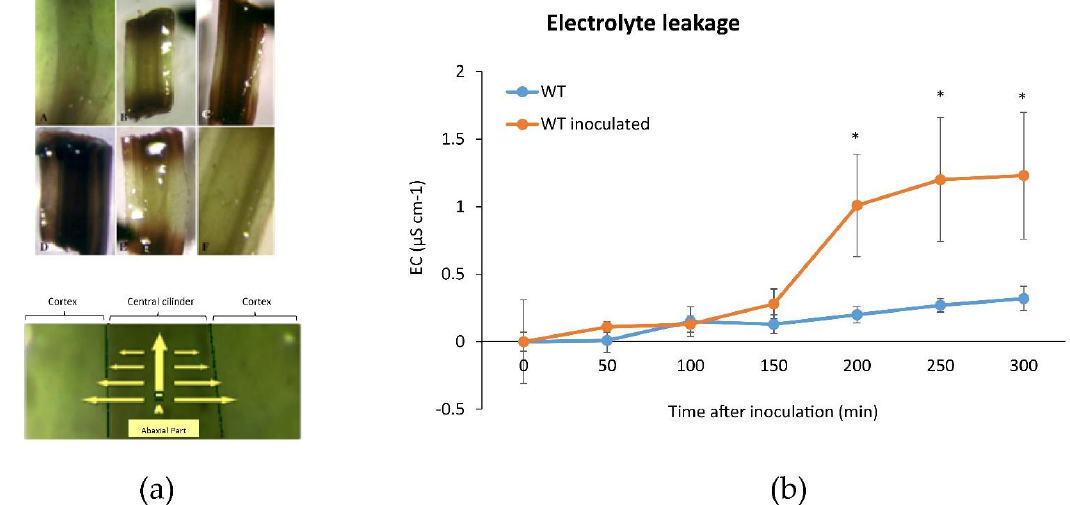
Figure 2. Oxidative activity in inoculated pear plantlets. ( a ) A schematic representation of the oxidative activity in inoculated plantlets with necrotic sections in the stem (upper panel) and necrotic progression from the central cylinder to the cortex, indicated by yellow arrows in the leaf (lower panel); ( b ) Representative data of the electrolyte leakage of inoculated and non-inoculated Dar Gazi-wt . Electrolytic conductivity dramatically increased in plants after bacterial inoculation. Error bars represent the SD of three independent experiments, each with three biological replicates. Asterisks indicate significant differences of inoculated vs non-inoculated plants (Student’s t -test, p ≤ 0.05).